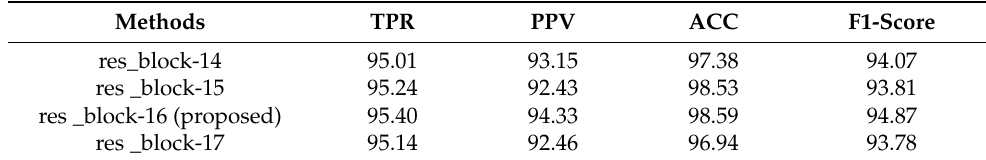
Table 15. Comparison of accuracies by the proposed PI-CNN and variants of CNN in the Fruits- 360 dataset.